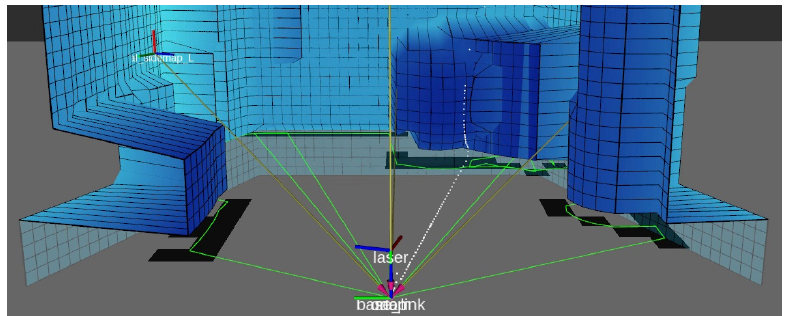
Figure 8. The green lines are the polygons that define the robot’s sight. Each square of the global map which has its center inside any of the three polygons will be cleaned. The local map was shifted one square up so that it is possible to see that the polygons follow the contour of the local